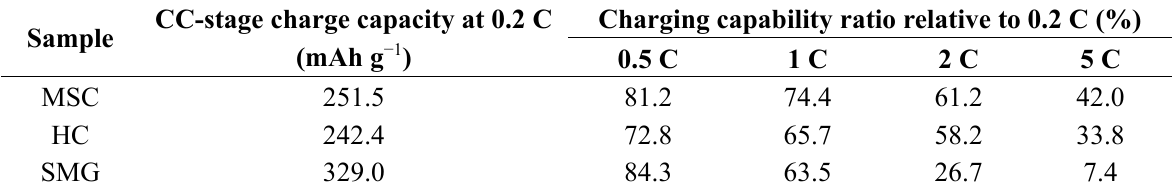
Figure 8. Plots of CC-stage charging capacity of the MSC, HC and SMG anode materials at various C-rates. Table 5. CC-stage charging capability ratio for the MSC, HC and SMG anode materials at various